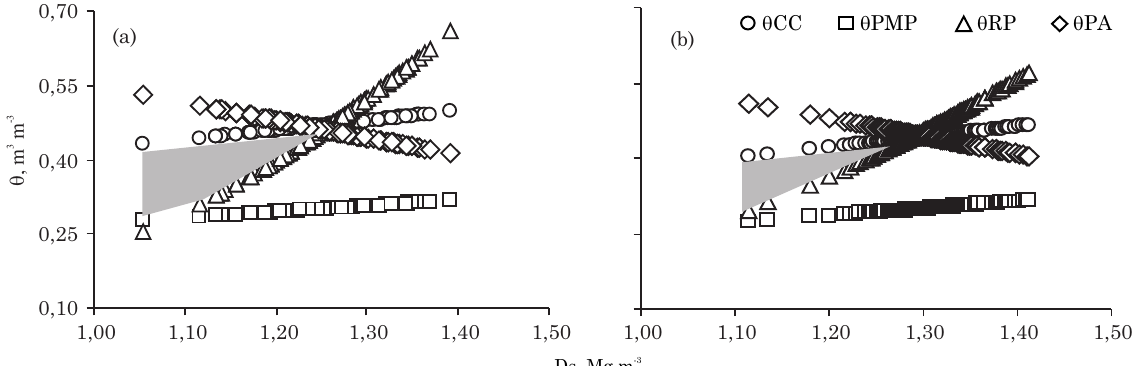
Figura 1. Variação do teor de água do solo ( θθθθθ ) com a densidade do solo (Ds) nos níveis críticos da capacidade de campo ( θθθθθ CC ), ponto de murcha permanente ( θθθθθ PMP ), resistência à penetração ( θθθθθ RP ) e porosidade de aeração ( θθθθθ PA ) nas camadas de 0,0-7,5 (a) e 7,5-15,0 cm (b). As áreas em cinza correspondem ao